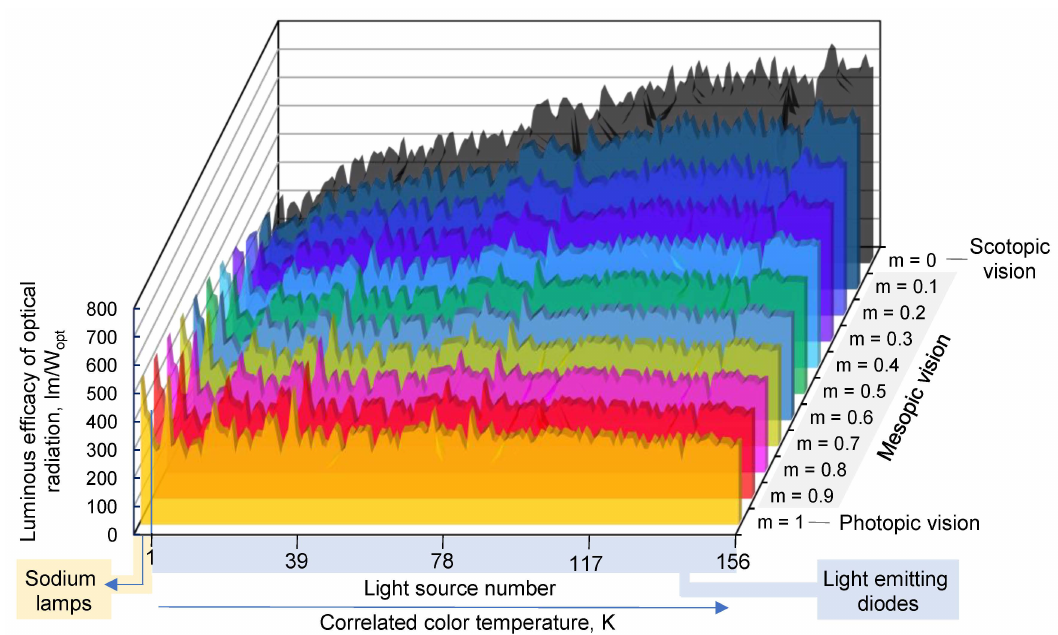
Figure 7. Calculated values of the luminous efficacy of optical radiation (LER) for 3 sodium lamps and 156 LED sources with different values of the correlated color temperature for photopic vision, mesopic vision, and scotopic